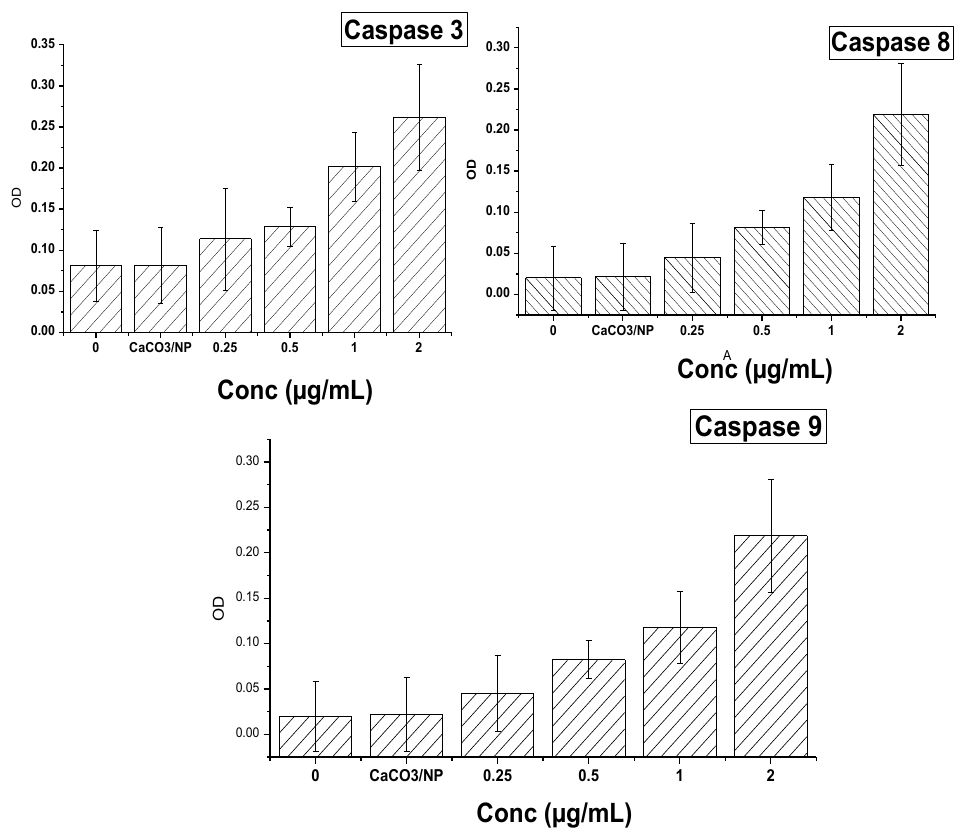
Figure 11. The effect of CaCO caspase-9 in MG 63